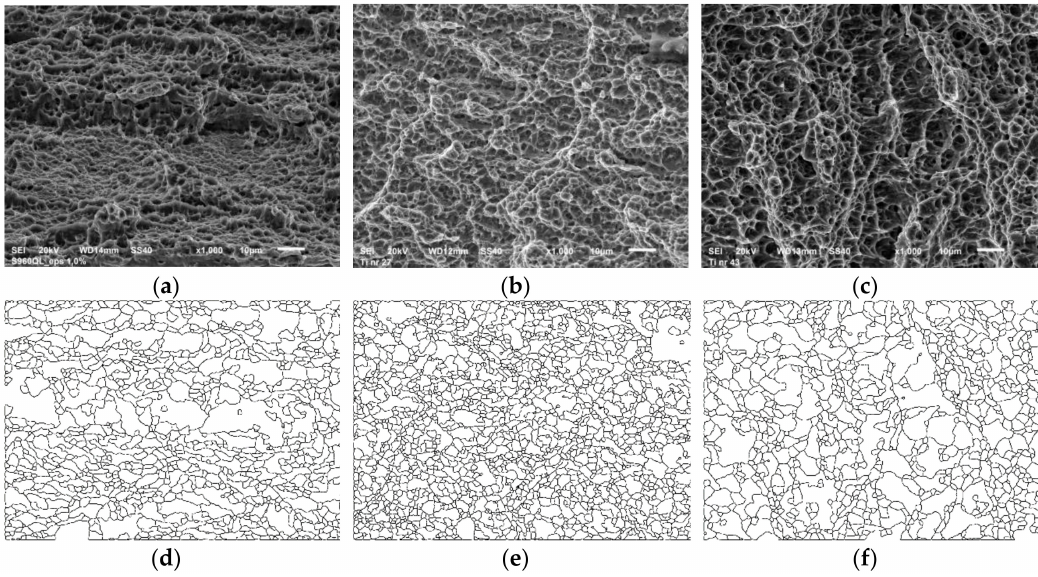
Figure 5. Initial images of fracture surfaces of the titanium alloy VT23 under SS ( a ), DNP1 ( b ), DNP2 ( c ), and the result of detecting the edges of dimples ( d – f ),